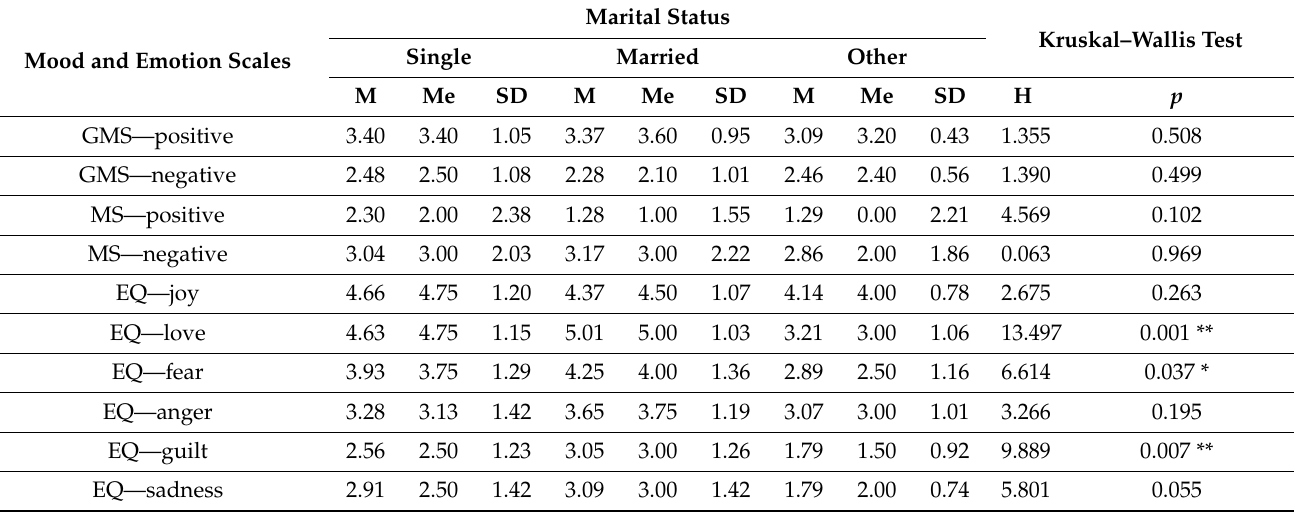
Table 4. Marital status and the mood and